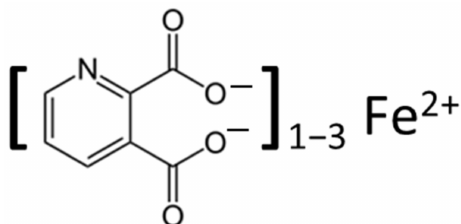
Figure 3. Chemical structure of the quinolinic acid iron complex. Vicinal oxygen groups (electron donors) in the molecule accounts for its coordination of Fe(II) [52], and the Fe(II)-complex can, through interaction with dioxygen and H 2 O 2 , lead to ROS generation [51,52]. Quinolinic acid has also been noted to increase phosphorylation of proteins involved in cellular structures, leading to destabilisation of the cytoskeleton. The various neu- rocognitive disorders attributed to or aggravated by increased levels of quinolinic acid are discussed in the following paragraphs